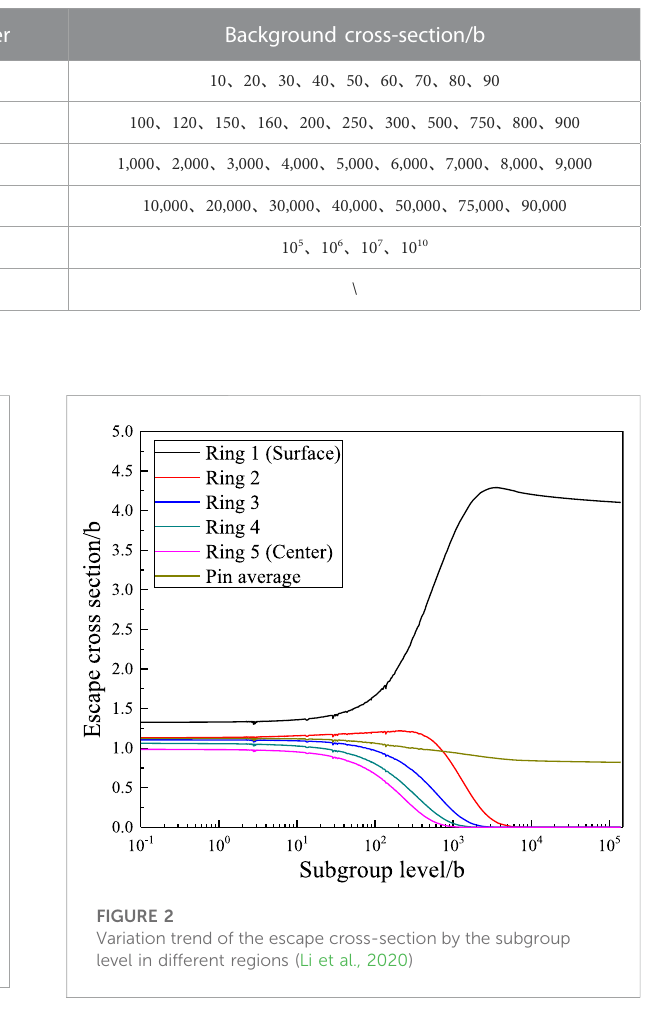
TABLE 3 Background cross sections of resonance integral.